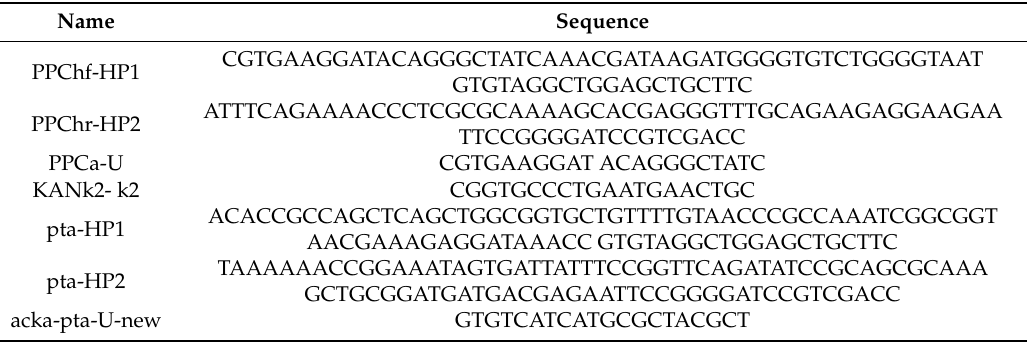
Table 2. Primers used in this